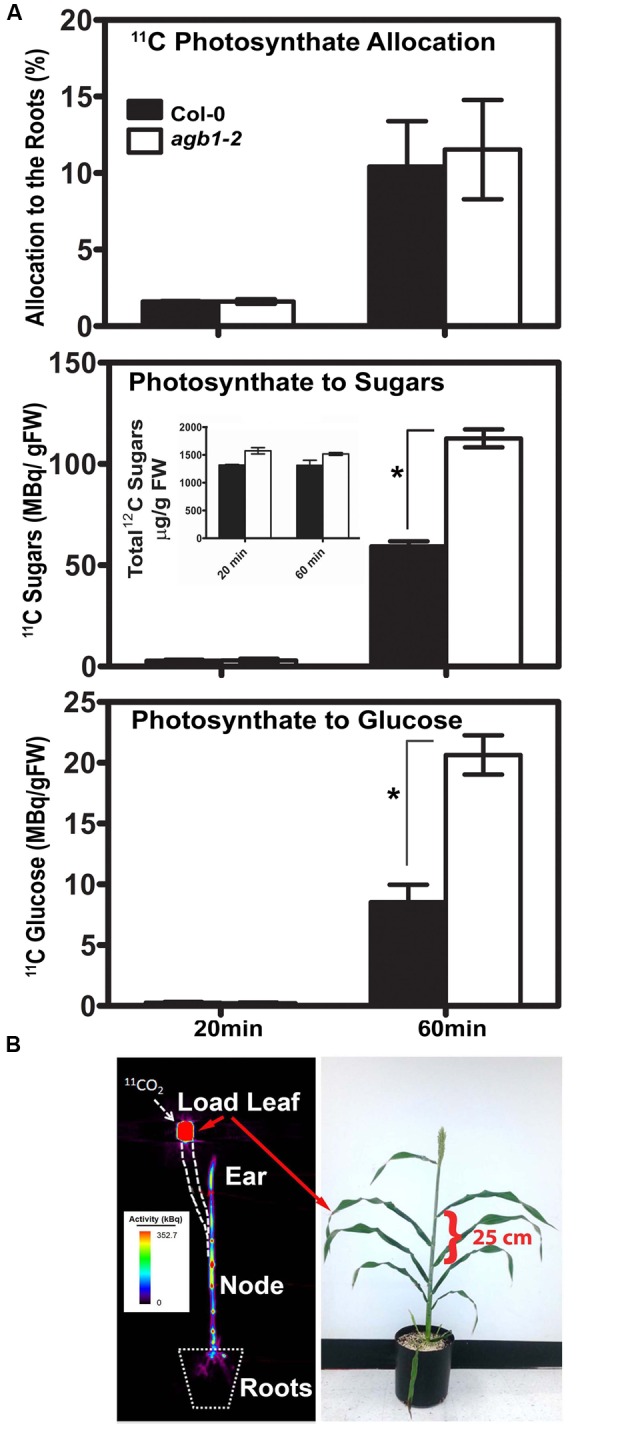
Positron electron tomography imaging of allocation and partitioning of photoassimilate. (A) Top panel. Total allocation of [11C] CO2 in the roots of Col (solid bars) and agb1-2 (open bars) at the indicated times. Middle panel. Partitioning of newly fixed 11CO2 to soluble sugars (glucose, fructose and sucrose) in the roots of Col (solid bars) and agb1-2 (open bars) at the indicated times. (Inset) Total non-radioactive [12C] sugars (glucose, fructose and sucrose) in the roots of Col (solid bars) and agb1-2 (open bars) at the indicated times. Non-radioactive [12C] sugars were extracted and analyzed by thin layer chromatography as described previously (Babst et al., 2013). Numbers represent the average of 3 independent experiments (n = 10 each) and error bars represent SE. Lower panel. Partitioning of newly fixed 11CO2 to glucose in the roots. Percentage values were calculated as radioactivity in the roots relative to the total seedling activity. Radioactivity (MBq/g FW) represent the mean of 3 independent experiments (n = 10 each) and error bars represent the standard error. (B) Fixed carbon is rapidly distributed to tissue sinks. (Left panel) The image shows the distribution of 11C-labeled photoassimilate in different parts of in an intact sorghum plant shown in the right panel imaged 2 h after 11CO2 administration to the load leaf at the position indicated. Heat scale represents activity/pixel. Load leaf = site of 11CO2 administration. Velocity was 1.25 cm min-1. A distance of 25 cm is indicated by the bracket. Student’s t-test results are based on difference between the means. Asterisks indicate P < 0.001.